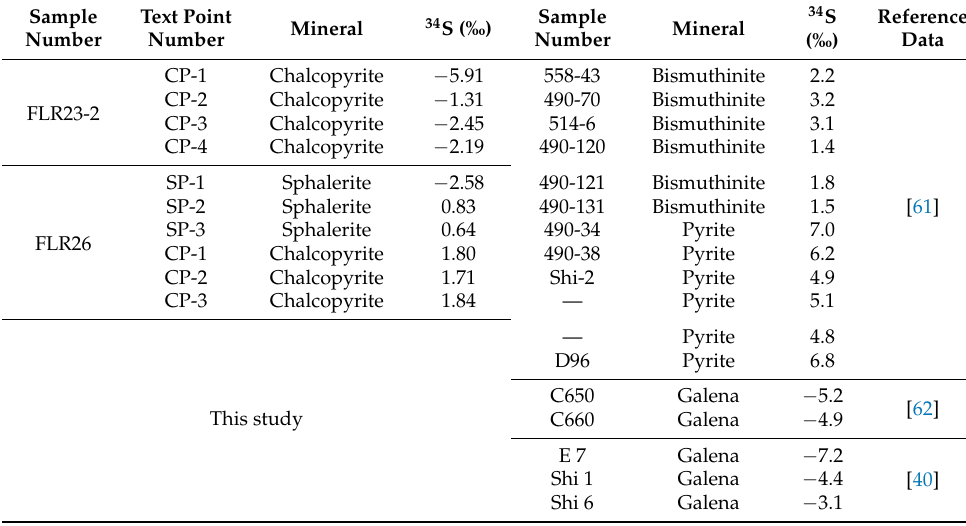
Table 4. In situ S isotope data of the Hongqiling Sn-W polymetallic